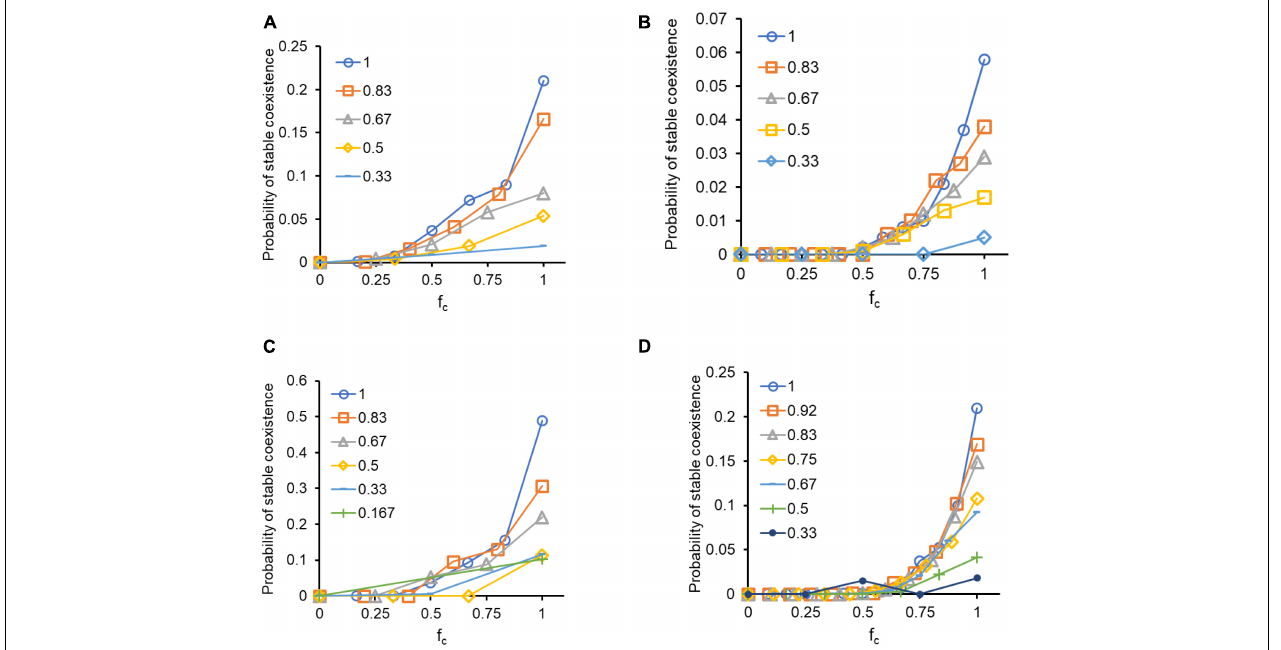
FIGURE 3 | A higher connectance and a higher fraction of synergistic interactions, both, independently, facilitate coexistence. In the replicator formulation, three- (A) and four-species (B) systems exhibit greater likelihood of coexistence as the number of interactions which are positive increases. In the Lotka-Volterra formulation, three- (C) and four-species (D) systems exhibit greater likelihood of coexistence as the number of interactions which are positive increases. The strength of interactions in the randomized networks is chosen from an exponential distribution. Mean strength of antagonistic interactions was 0.1 and that of positive interaction was 0.05. The legend describes the value of c for each set of